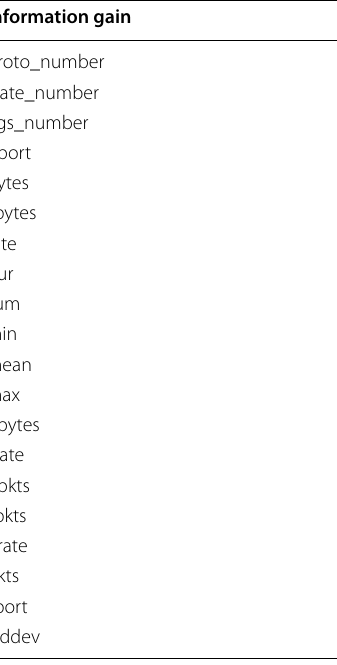
Table 56 Features by filter-based feature